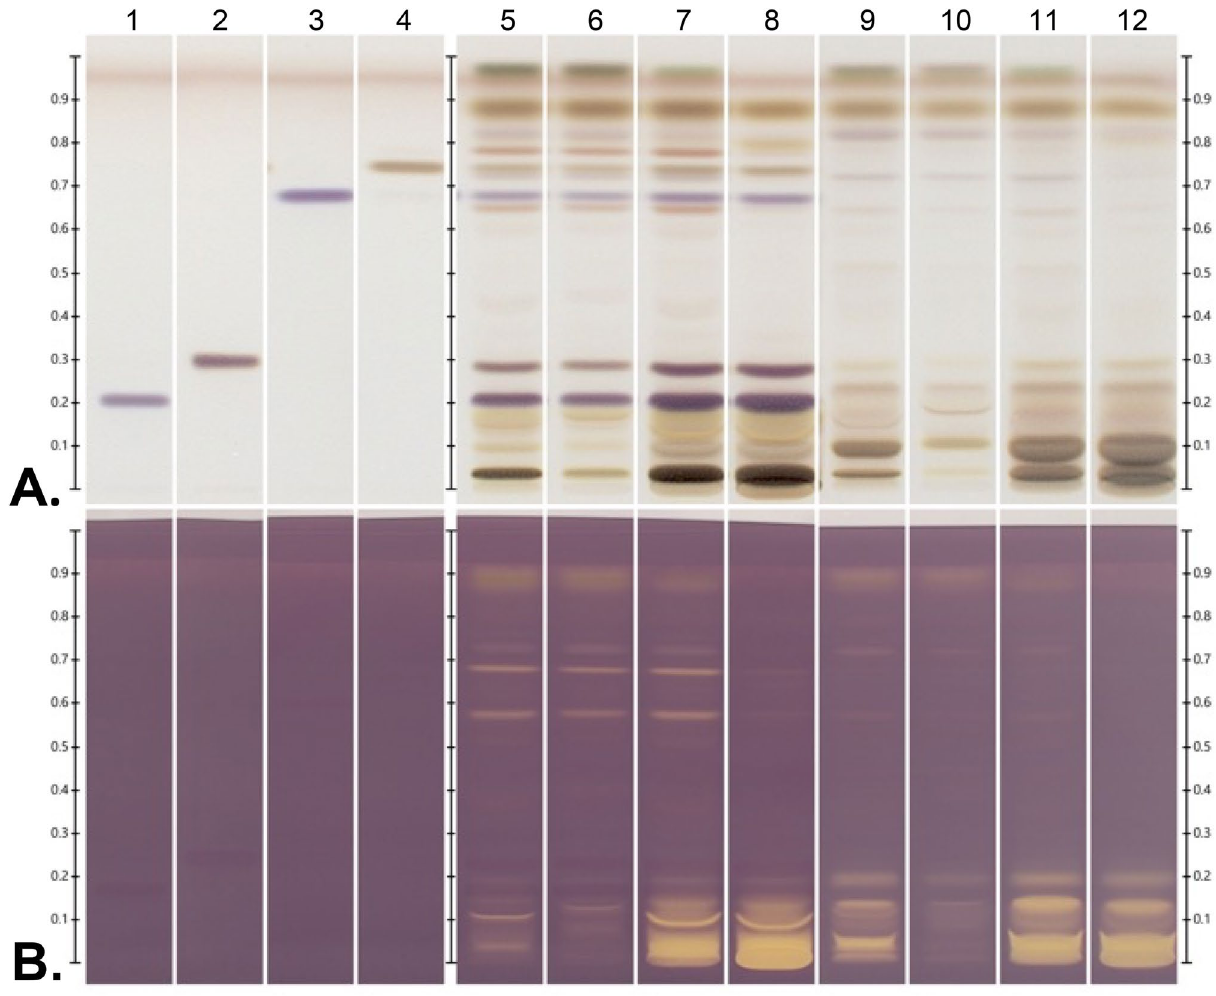
Figure 1. The antioxidant activities of Centella extracts are not due to asiaticoside, asiatic acid, madecassoside and madecassic acid. HPTLC fingerprints of triterpene standards ( 1 , madecassoside; 2 , asiaticoside; 3 madecassic acid; 4 , asiatic acid), APE ( 5 , methanol; 6 , 95 % ethanol; 7 , 70 % ethanol; 8 , 50 % ethanol), and CE ( 9 , methanol; 10 , 95 % ethanol; 11 , 70 % ethanol; 12 , 50 % ethanol). ( A ) The HPTLC plate was derivatized with anisaldehyde sulphuric acid reagent and visualized with white light. ( B ) The HPTLC plate was dipped with DPPH reagent and visualized with white